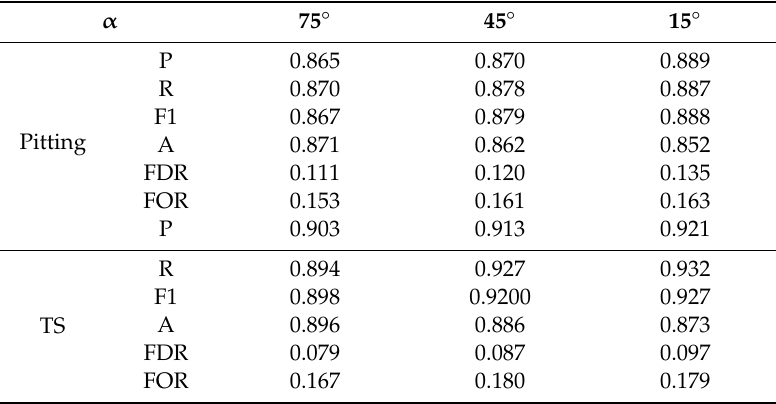
Table 5. Detection results under di ff erent shooting